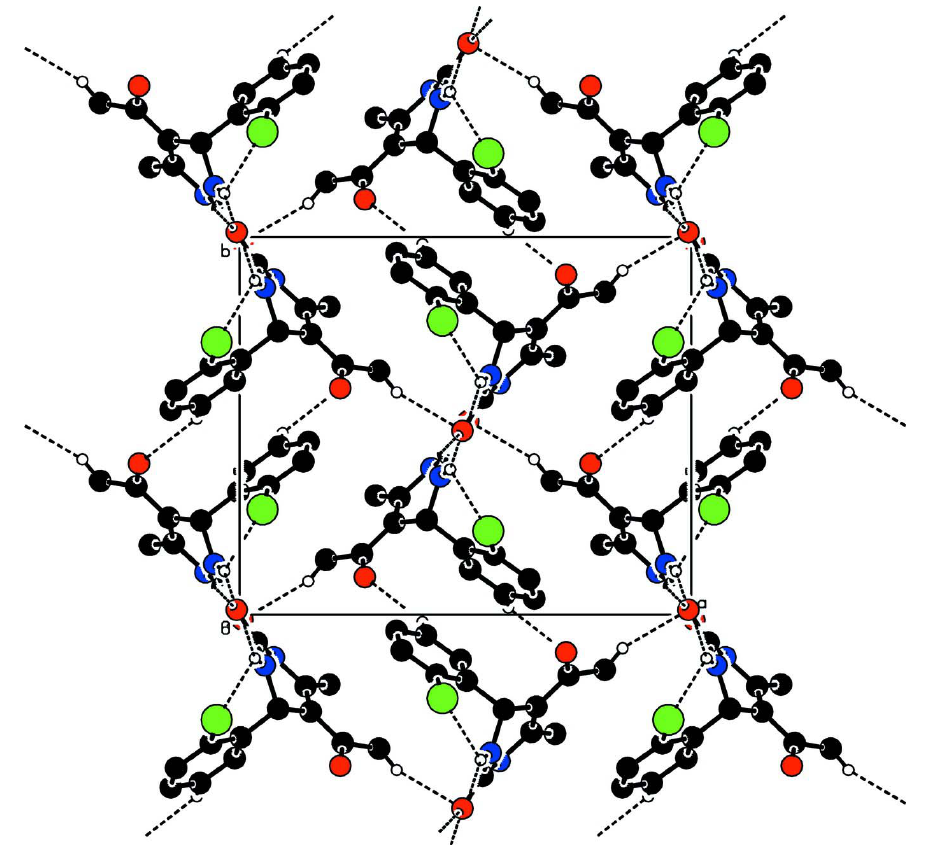
Figure 2 The crystal packing of (I), viewed down the c axis. Dashed lines indicate intermolecular contacts. H atoms not involved in hydrogen bonding have been